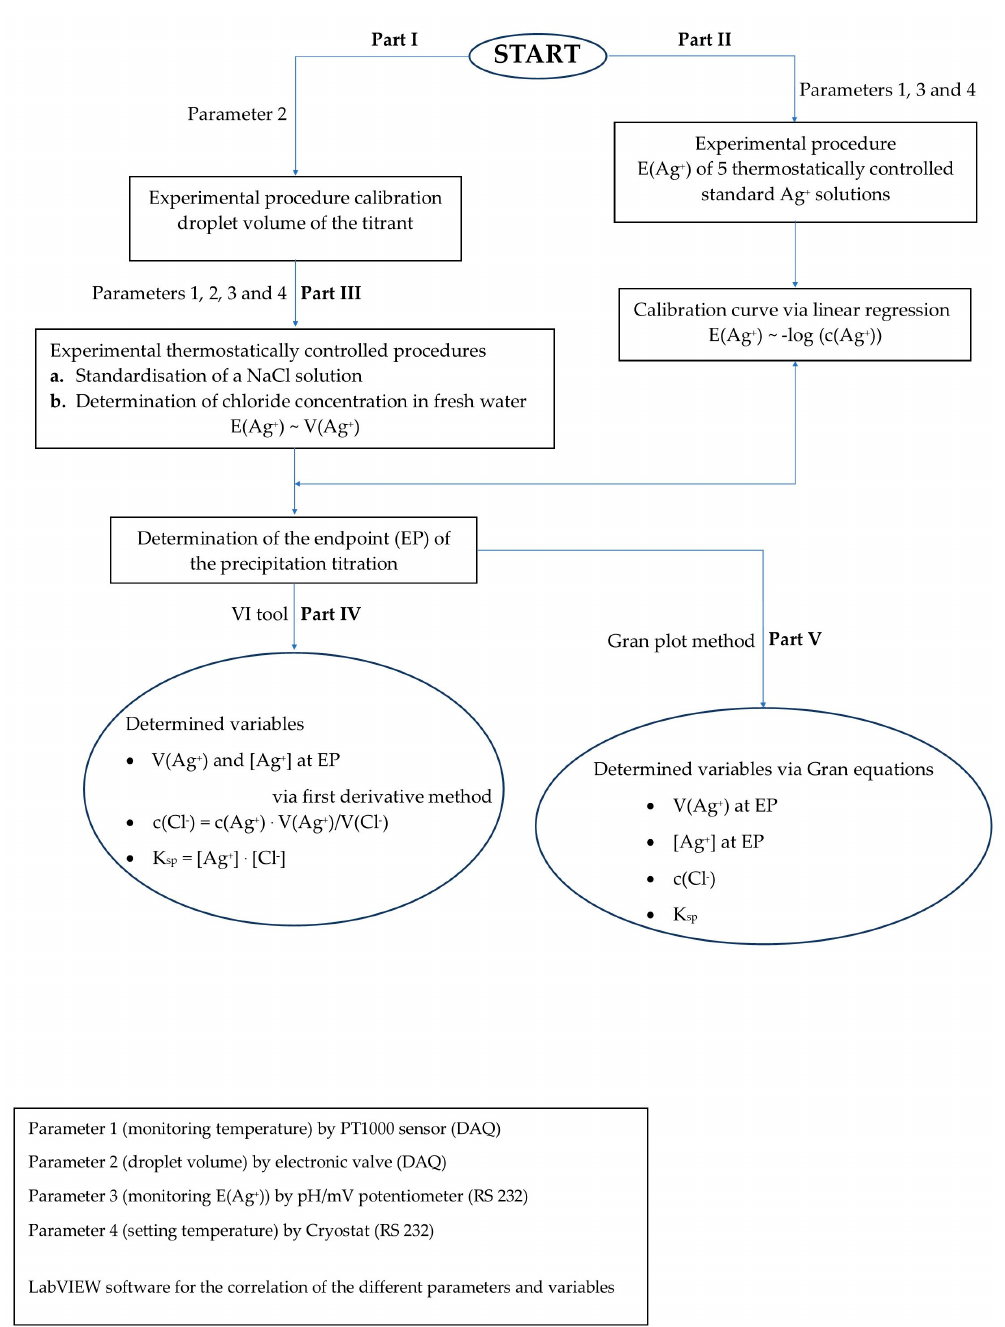
Scheme 1. Flow chart of the experimental procedure.